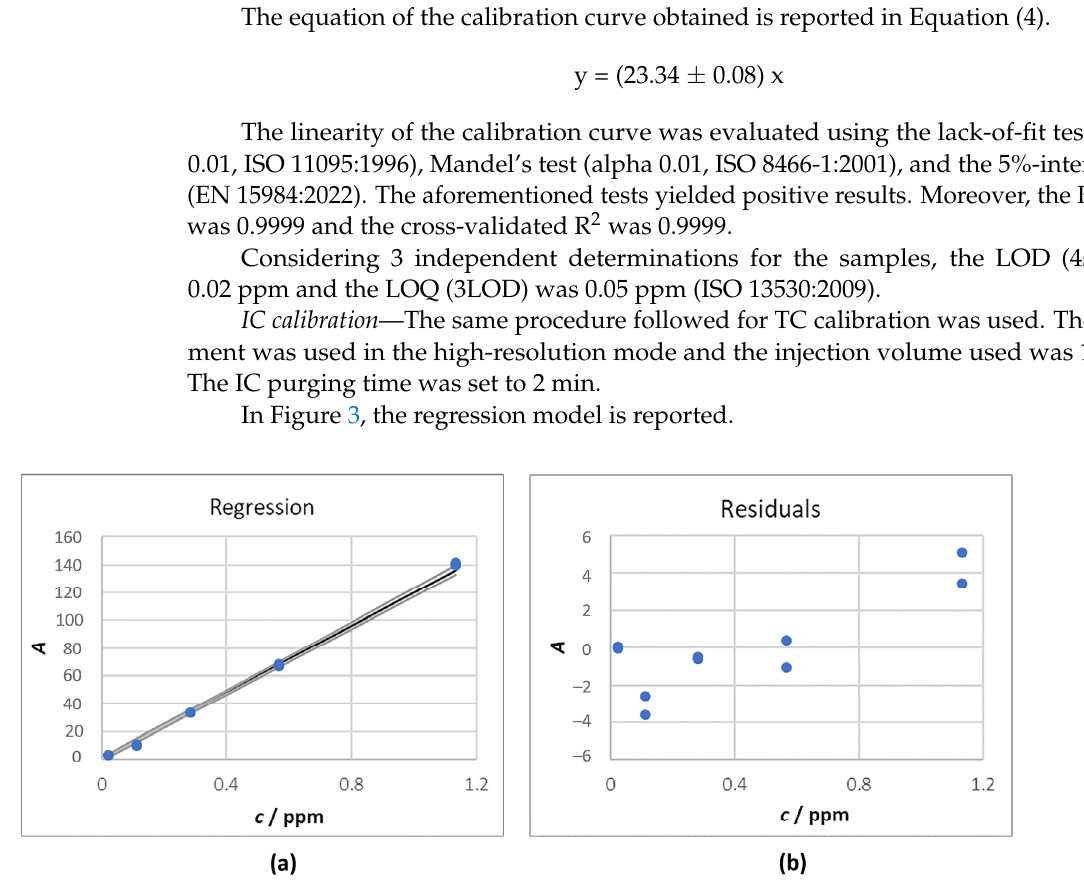
Figure 3. Calibration for IC: ( a ) Regression line obtained; ( b ) Residuals graph. The equation of the curve that was obtained is reported in Equation (5).